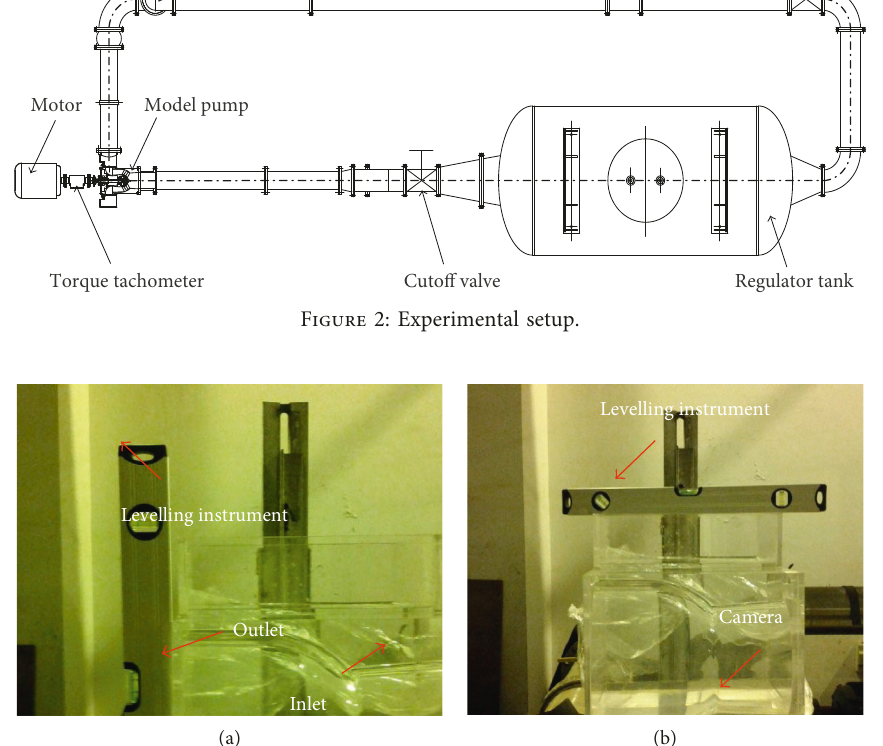
Figure 3: Calibration tank and calibration process. (a) To adjust the side surfaces in the same vertical plane. (b) To adjust the end surface in the horizontal